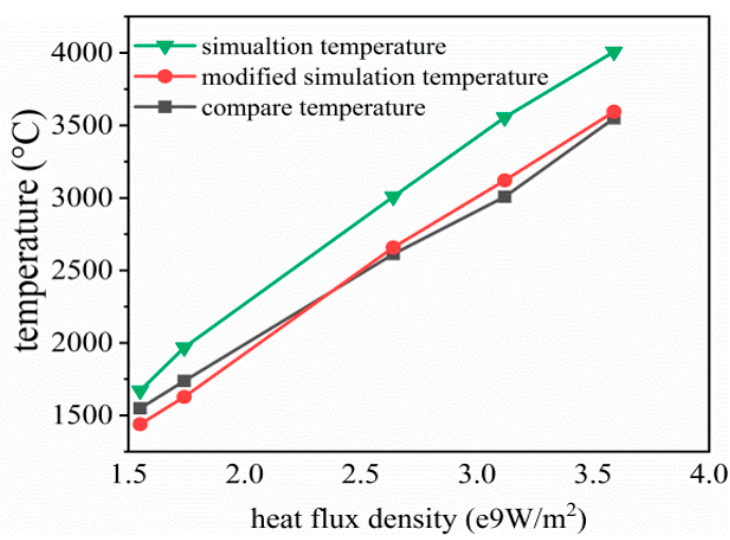
Figure 4. Comparison of the simulation model, modified simulation model, and temperature from the literature.